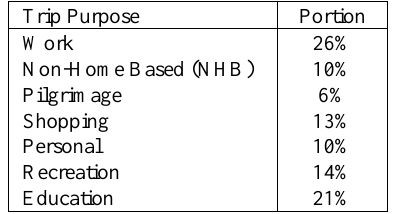
Table 1. Portion of trips based on purposes in Mashhad in 2018